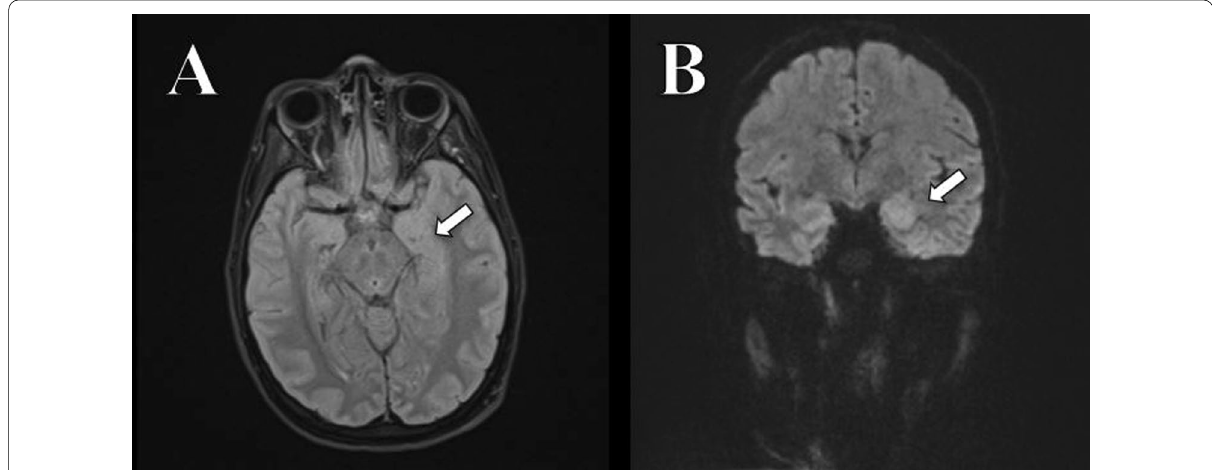
Fig. 1 T2 axial FLAIR ( A ) and resolve 3 scan trace ( B ) showing asymmetry of hippocampal regions with a significant restriction to the left